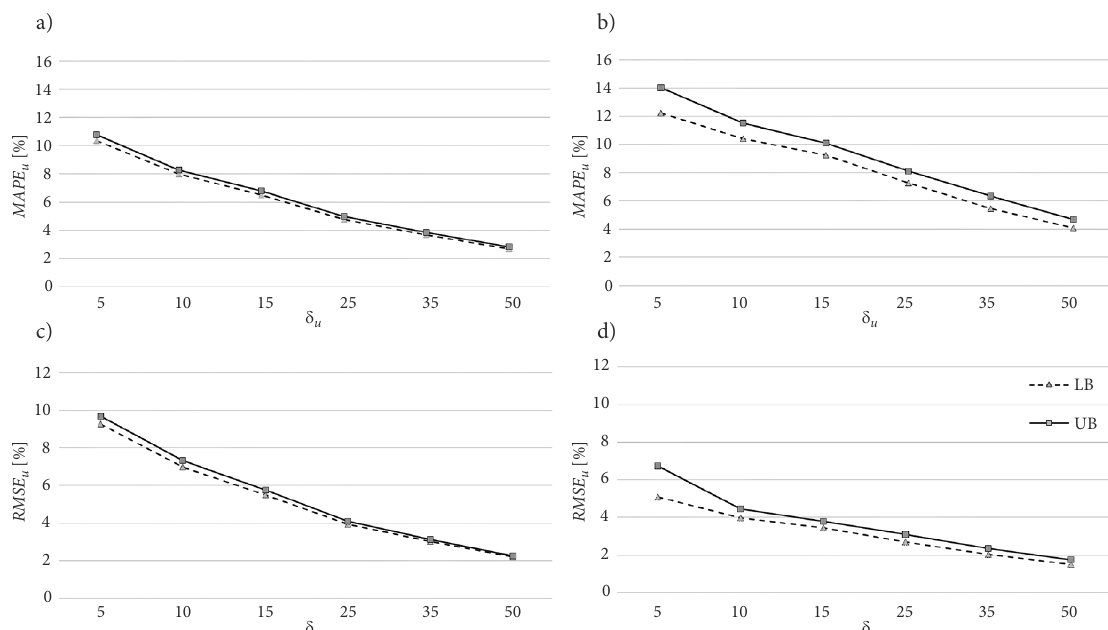
Figure 5. Variation of MAPE u and RMSE u performance for MC simulations during whole-analysis period (a, c), am-peak period (b, d)